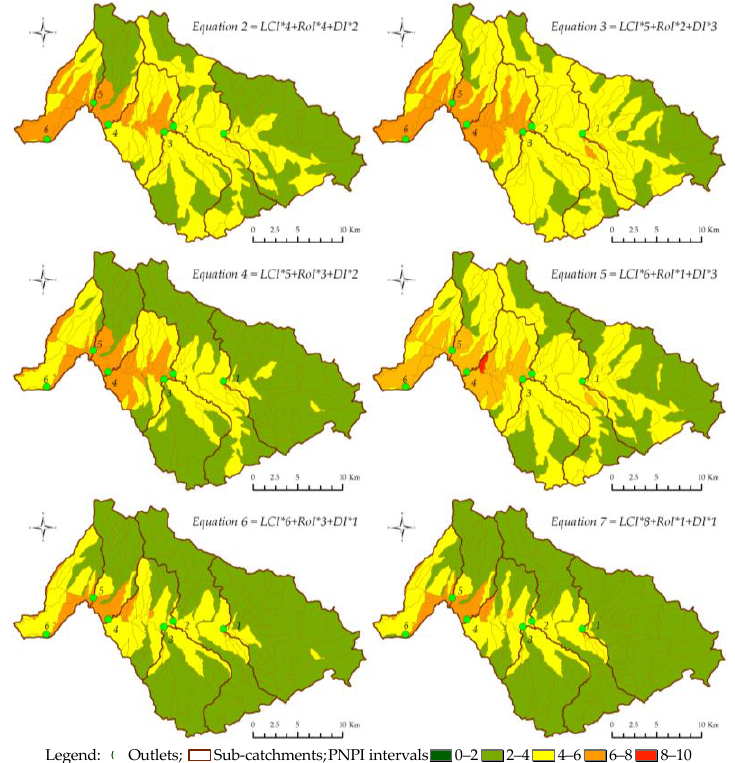
Figure 15. Spatial distribution of the different potential non-point pollution index (PNPI) classes at micro-catchment level in 2017.